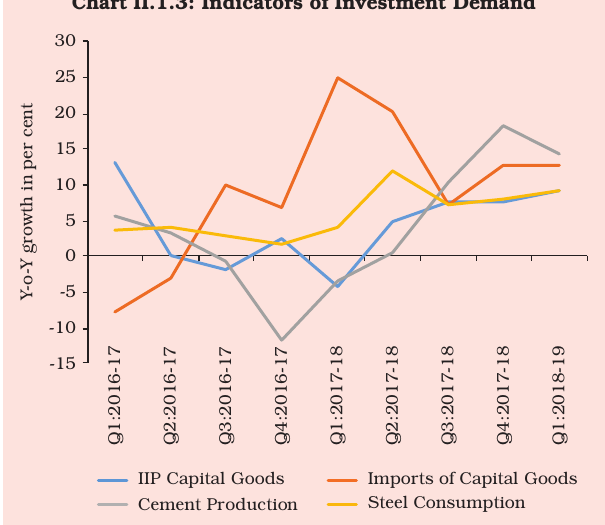
Chart II.1.3: Indicators of Investment